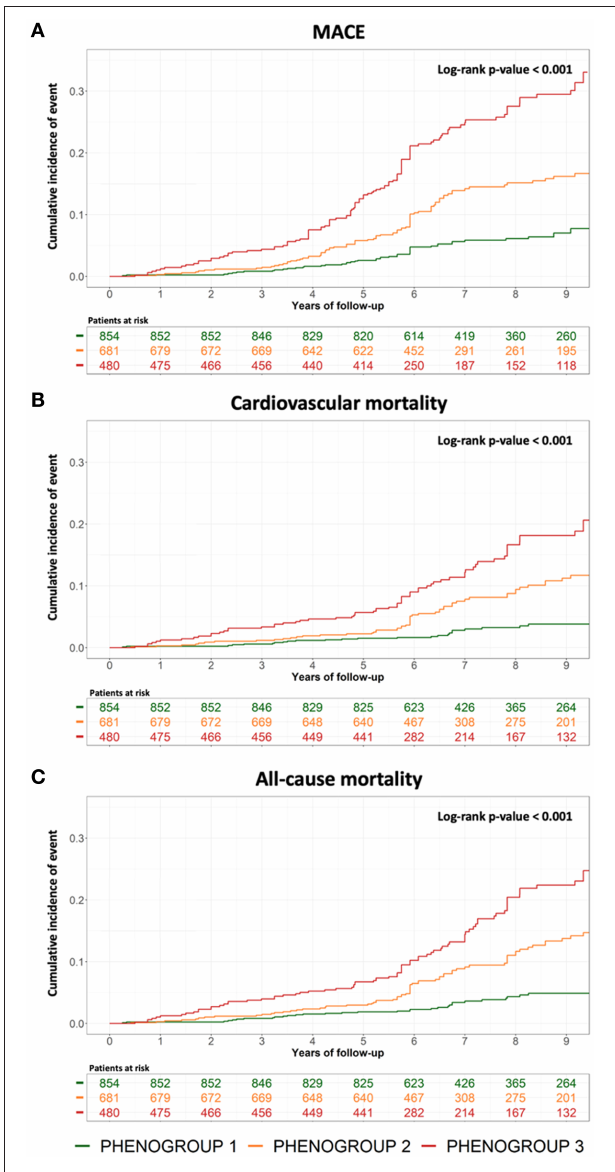
FIGURE 4 | Kaplan-Meier curves for MACE (A) , cardiovascular mortality (B) , and all-cause mortality (C) of the three phenogroups.